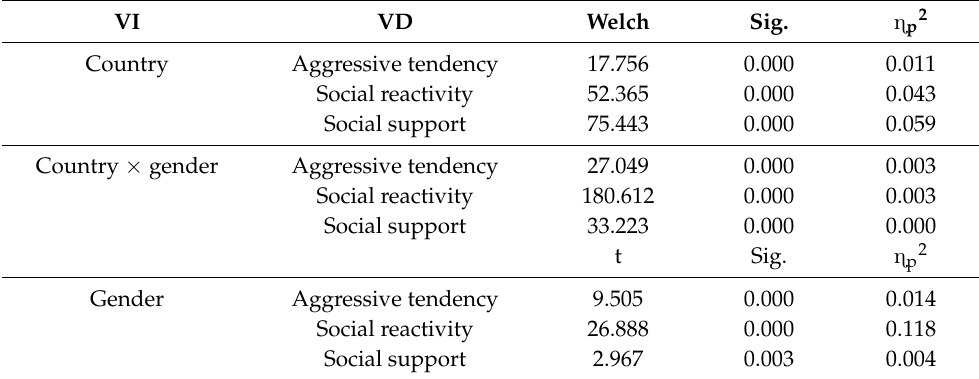
Table 4. Differences in emotional behaviour by country, country × gender, and